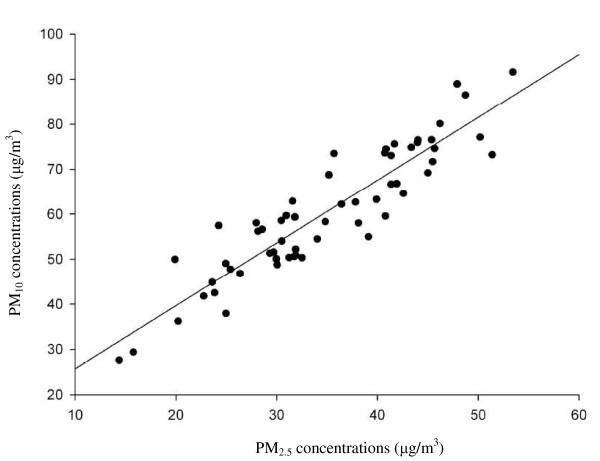
Correlation analyses between PM10 and PM2.5 from 60 township monitoring stations in 2006.